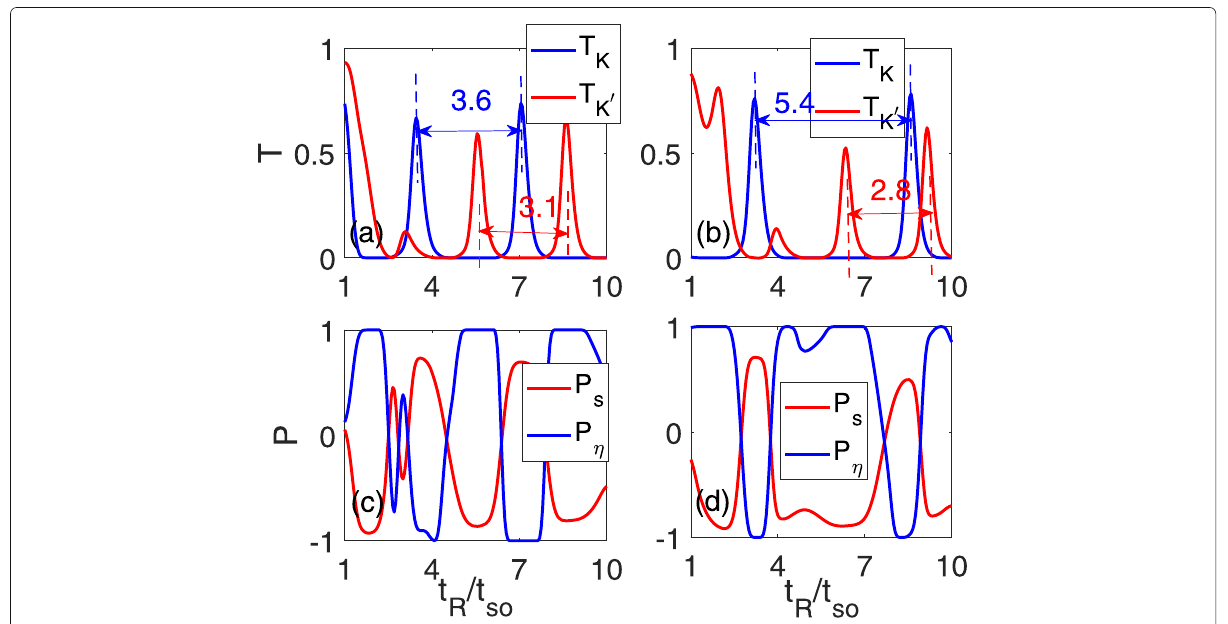
Fig. 3 The total transmission coefficients T K / T K (cid:2) ( a , b ) and the spin/valley polarization ( c , d ) as a function of the RSOC strength t R for different sublattice potentials. (cid:10) z = 0.15 t so in a and c and (cid:10) z = 0.3 t so in b and d ; the other parameters are identical to those in Fig.